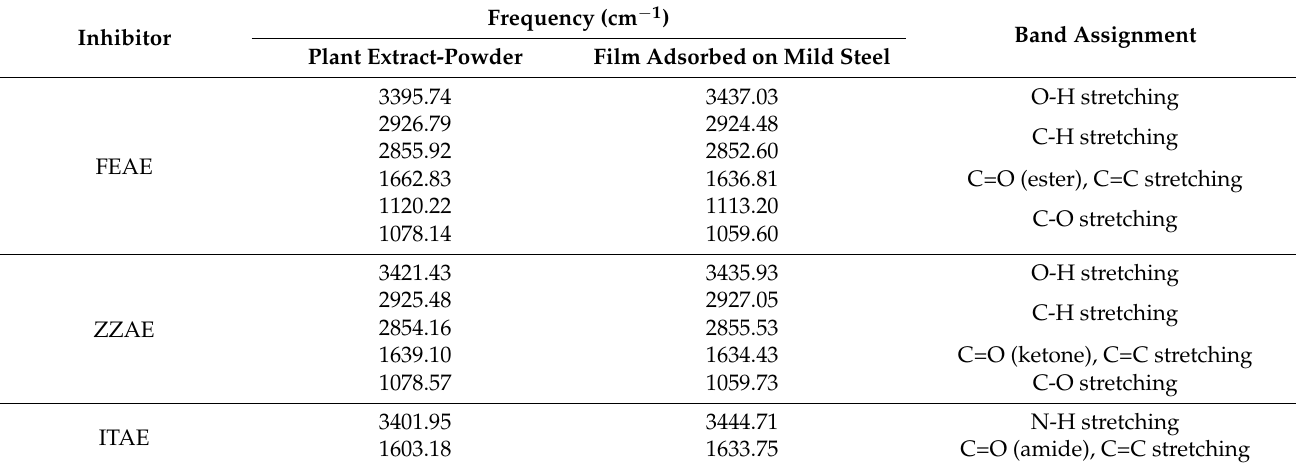
Table 5. Prominent peaks of FT-IR